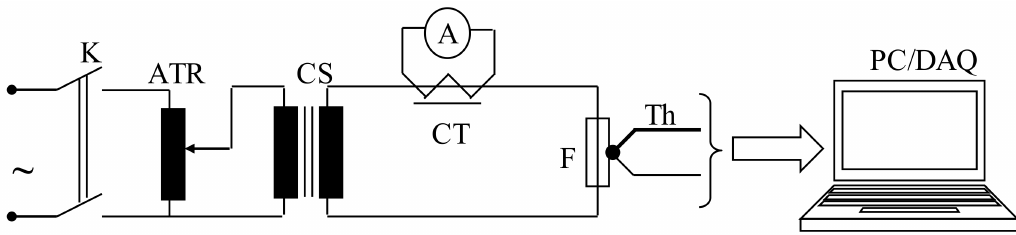
Figure 12. Experimental electric diagram.